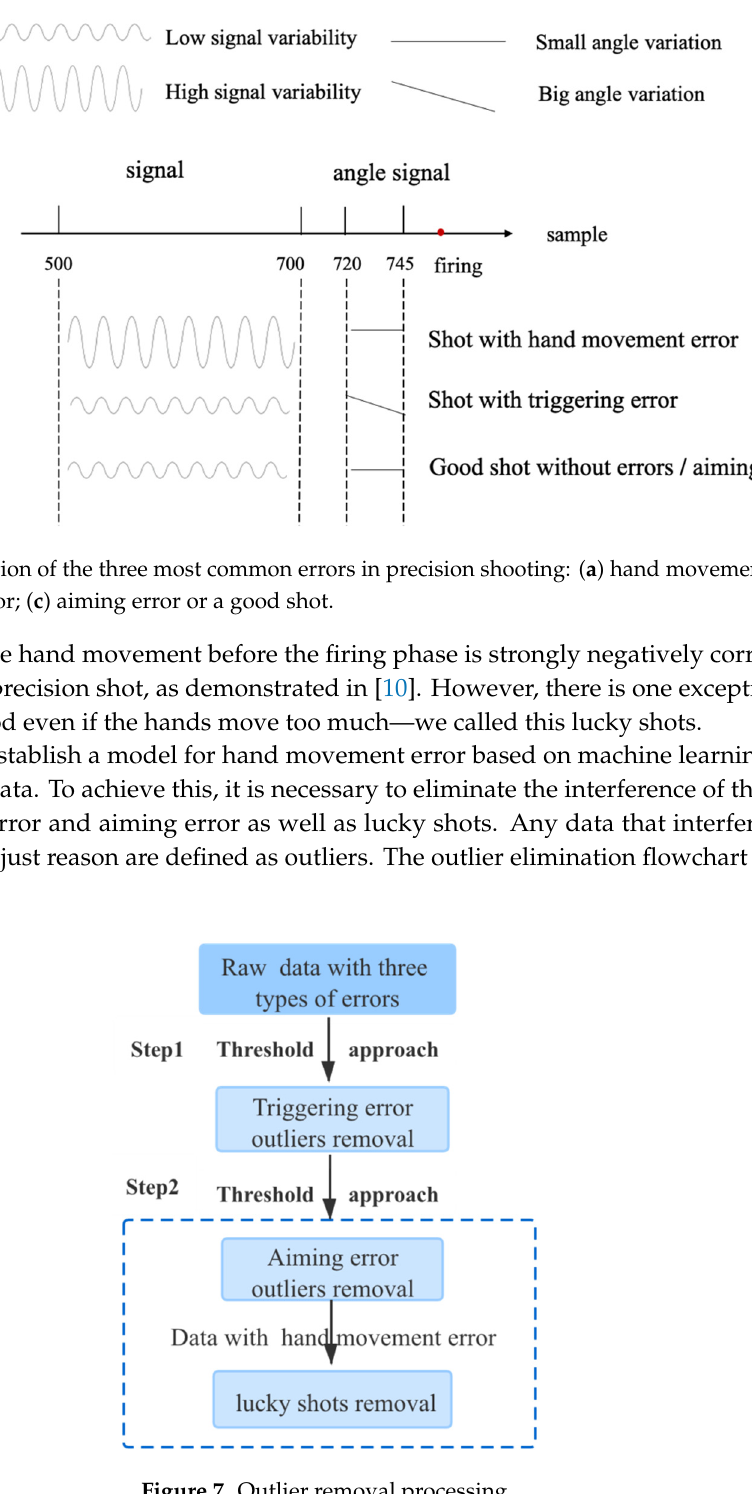
Figure 7. Outlier removal processing.